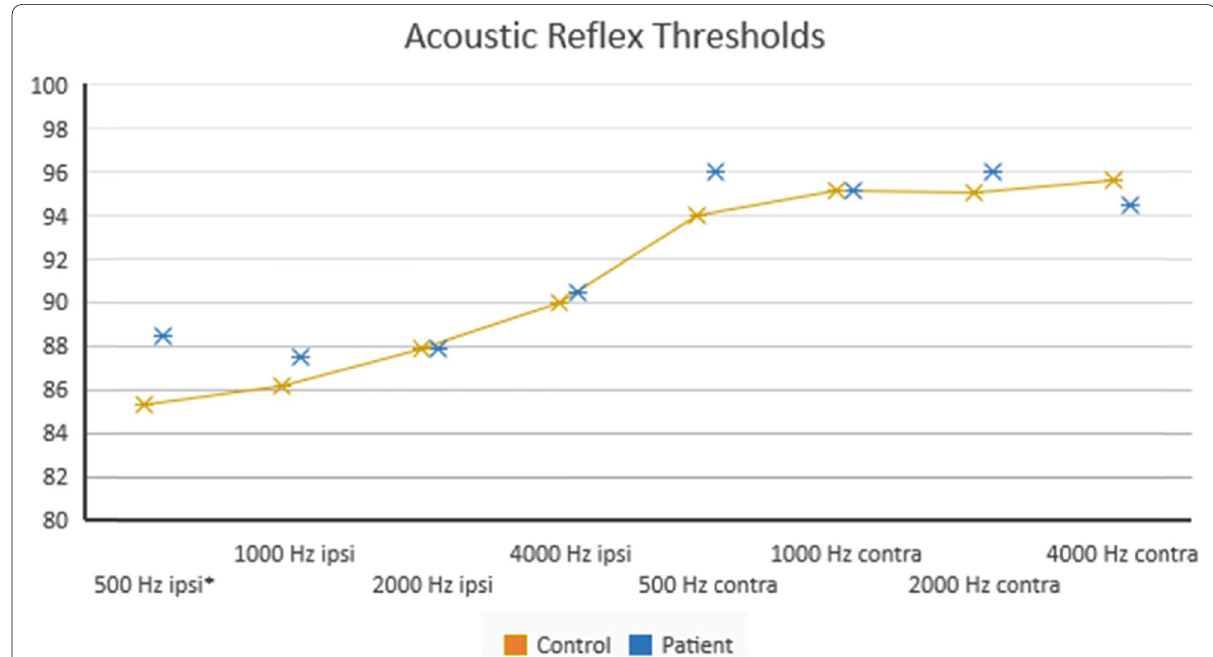
Fig. 2 Acoustic reflex thresholds of groups. In the patient group, the 500 Hz ipsilateral acoustic reflex thresholds were significantly higher [ p 0.024, p < 0.05]